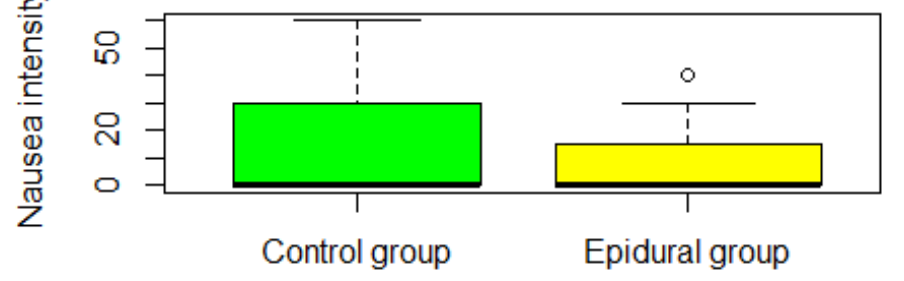
Figure 5. The VAS nausea intensity measured the worst patient score in the first postoperative day. This distribution is shifted toward zero, therefore the median is zero and the box is shorted.